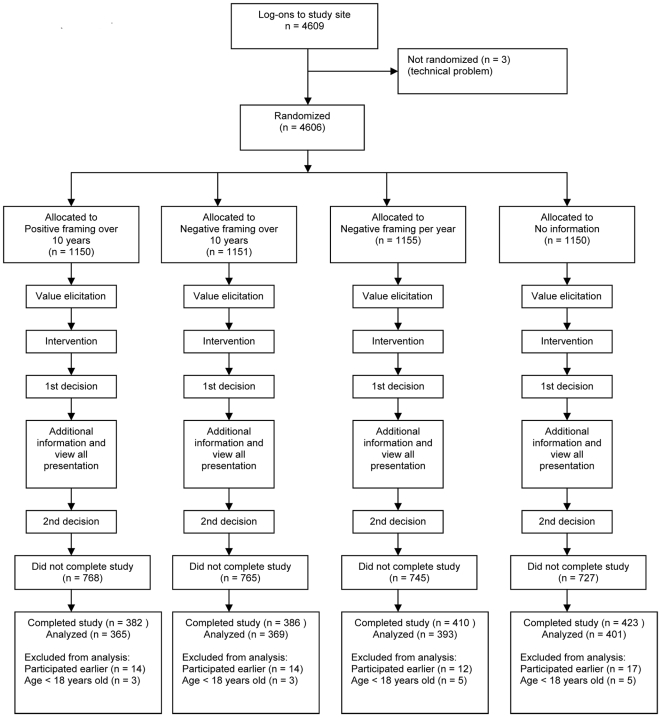
CONSORT flow-chart.